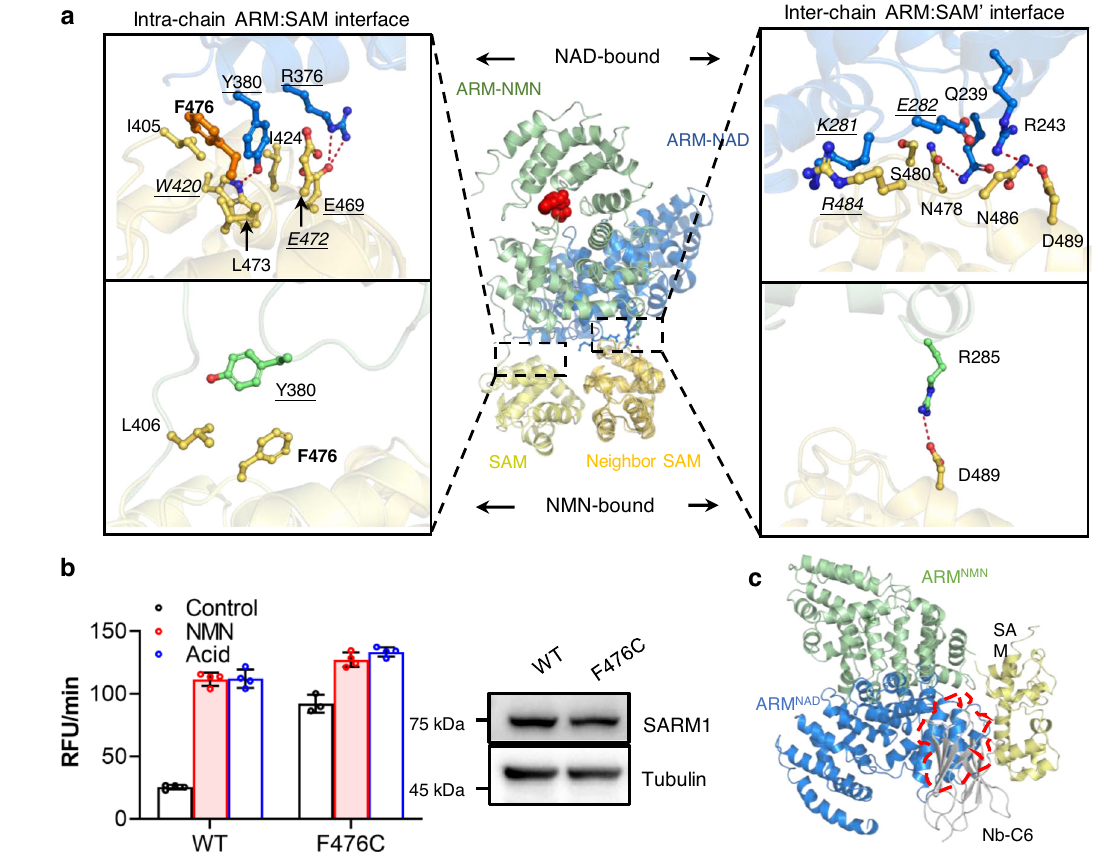
Fig.5|ReleasingARMfromSAMdomainallowsNb-C6binding.a Superposition of SARM1 NMN onto SARM1 NAD (PDB 7CM6) via the SAM domains. Left panels: intra- chain ARM-SAM interfaces; Right panels: inter-chain ARM-SAM ’ interfaces; Upper panels: NAD-bound; lower panels: NMN-bound. The ARM and SAM domains are shown in green and gold in SARM1 NMN , respectively; and they are colored in blue andorangeinSARM1 NAD ,respectively.Keyinteractionresiduesattheinterfacesare showninball-and-stickmodelsandlabeled.TheH-bondsandsalt-bridgeareshown as red dash lines. The residues mutated in this work are labeled in bold and the